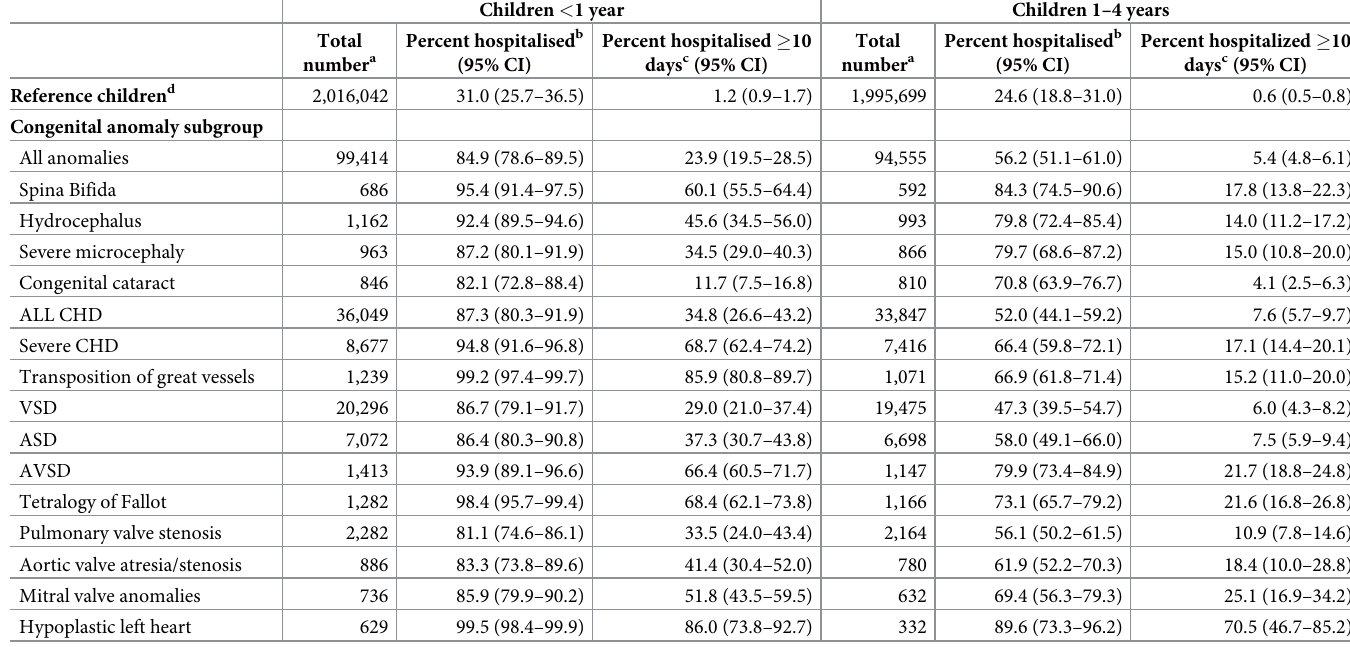
Table 2. Meta-analysis of percentage hospitalised and percentage with a long stay ( � 10 days) according to congenital anomaly subgroup and